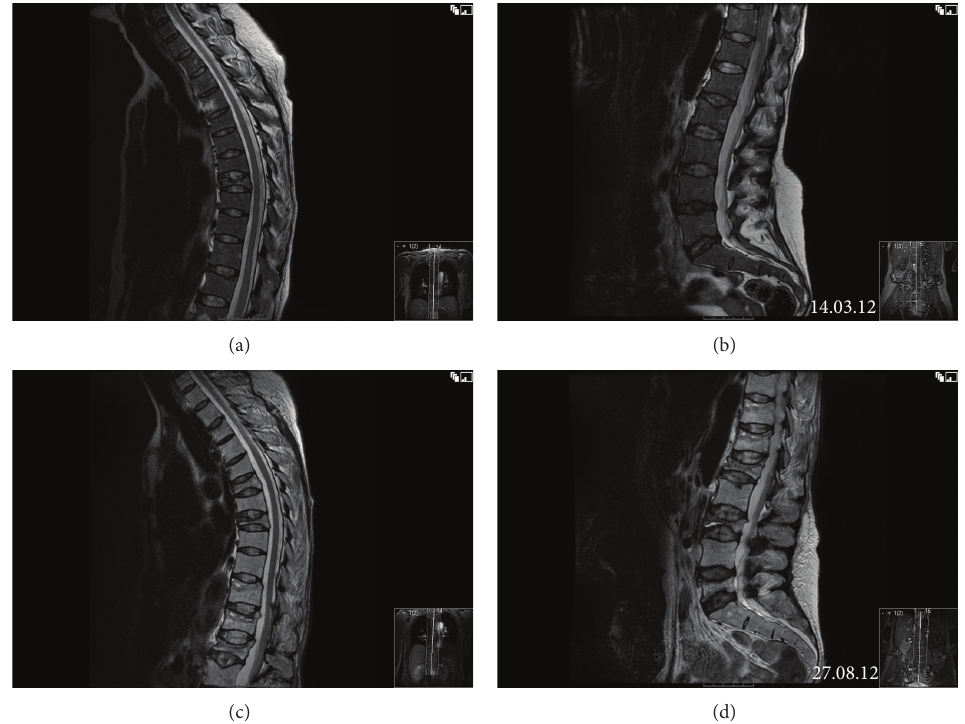
Figure 4: MRI spine. T2 fat-saturated axial view at the initial staging showed a compression fracture of T8 (a) and no other osseous lesions (a, b). Five months later, appearances were suspicious for lymphomatous infiltration with abnormal signal in T11 and T12 vertebral bodies and multilevel compression fractures of thoracic spine (c) and lumbar spine